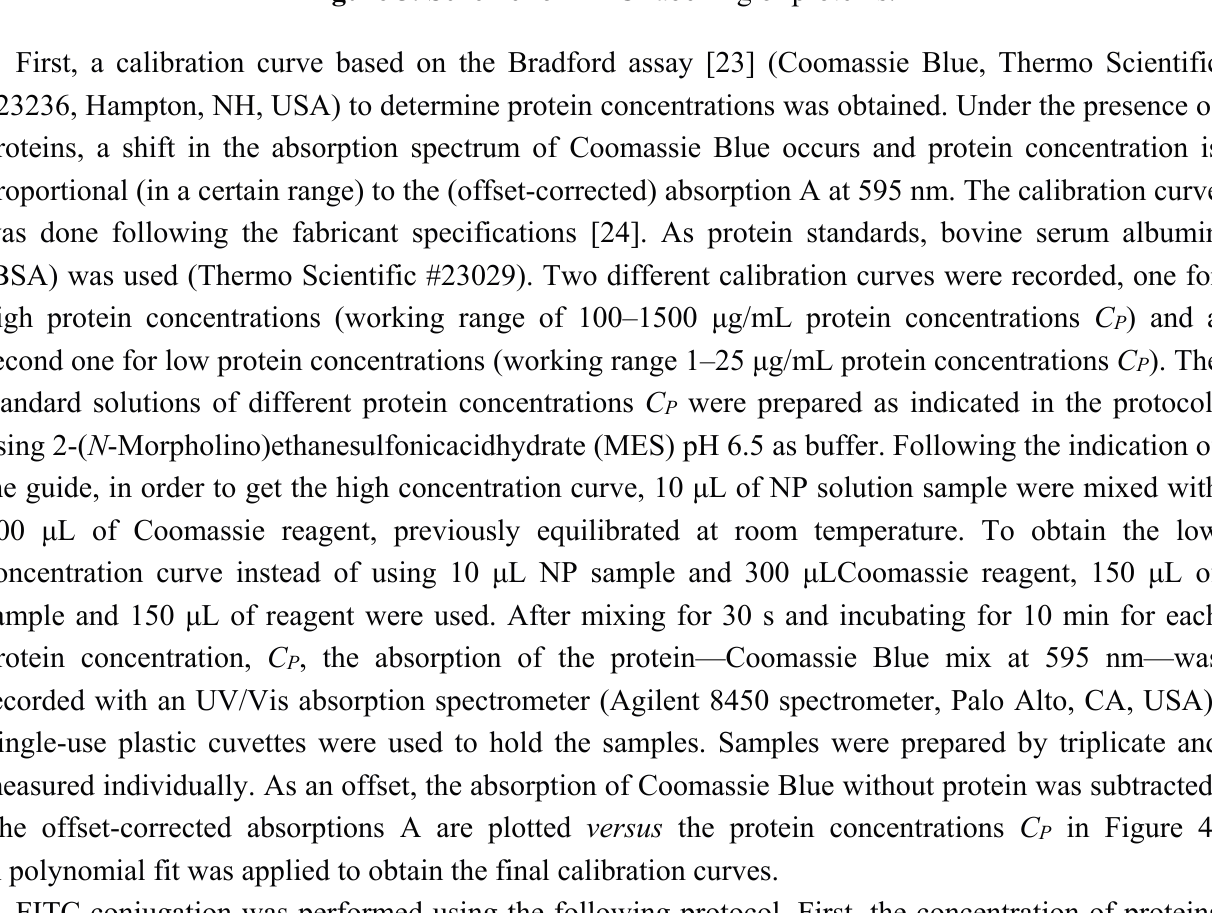
Figure 3. Scheme for FITC-labelling of